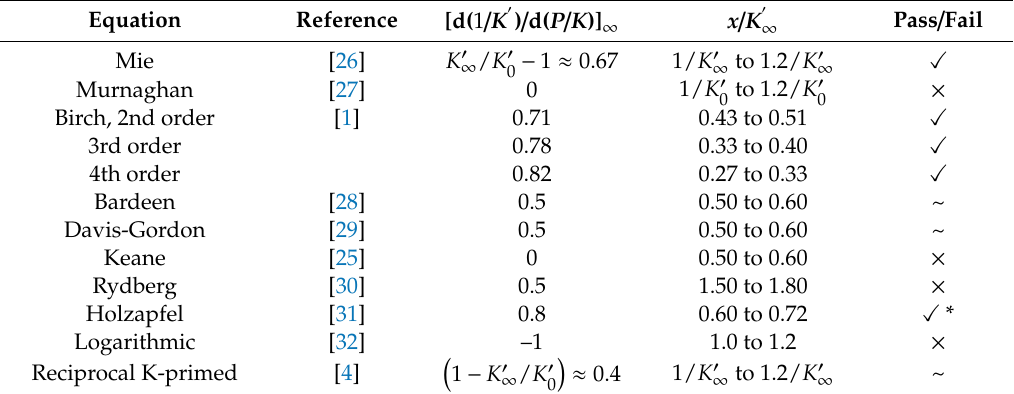
Table 1. Values of the parameters in Equation (19) for selected equations of